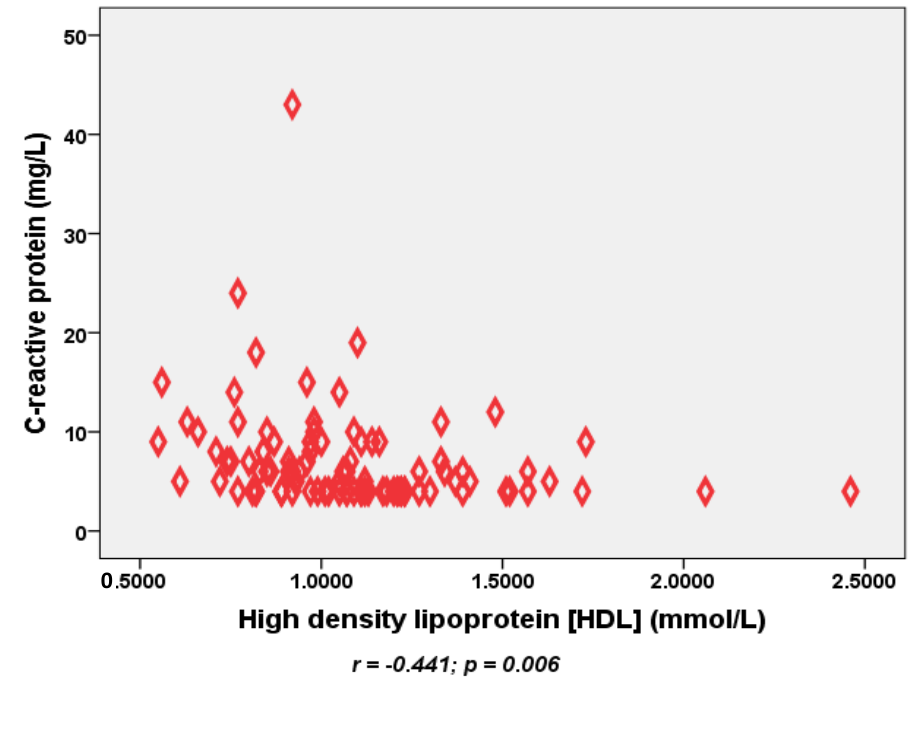
Figure. 1 Association between the inflammatory marker C-reactive protein and high density lipoproteins in obese diabetic